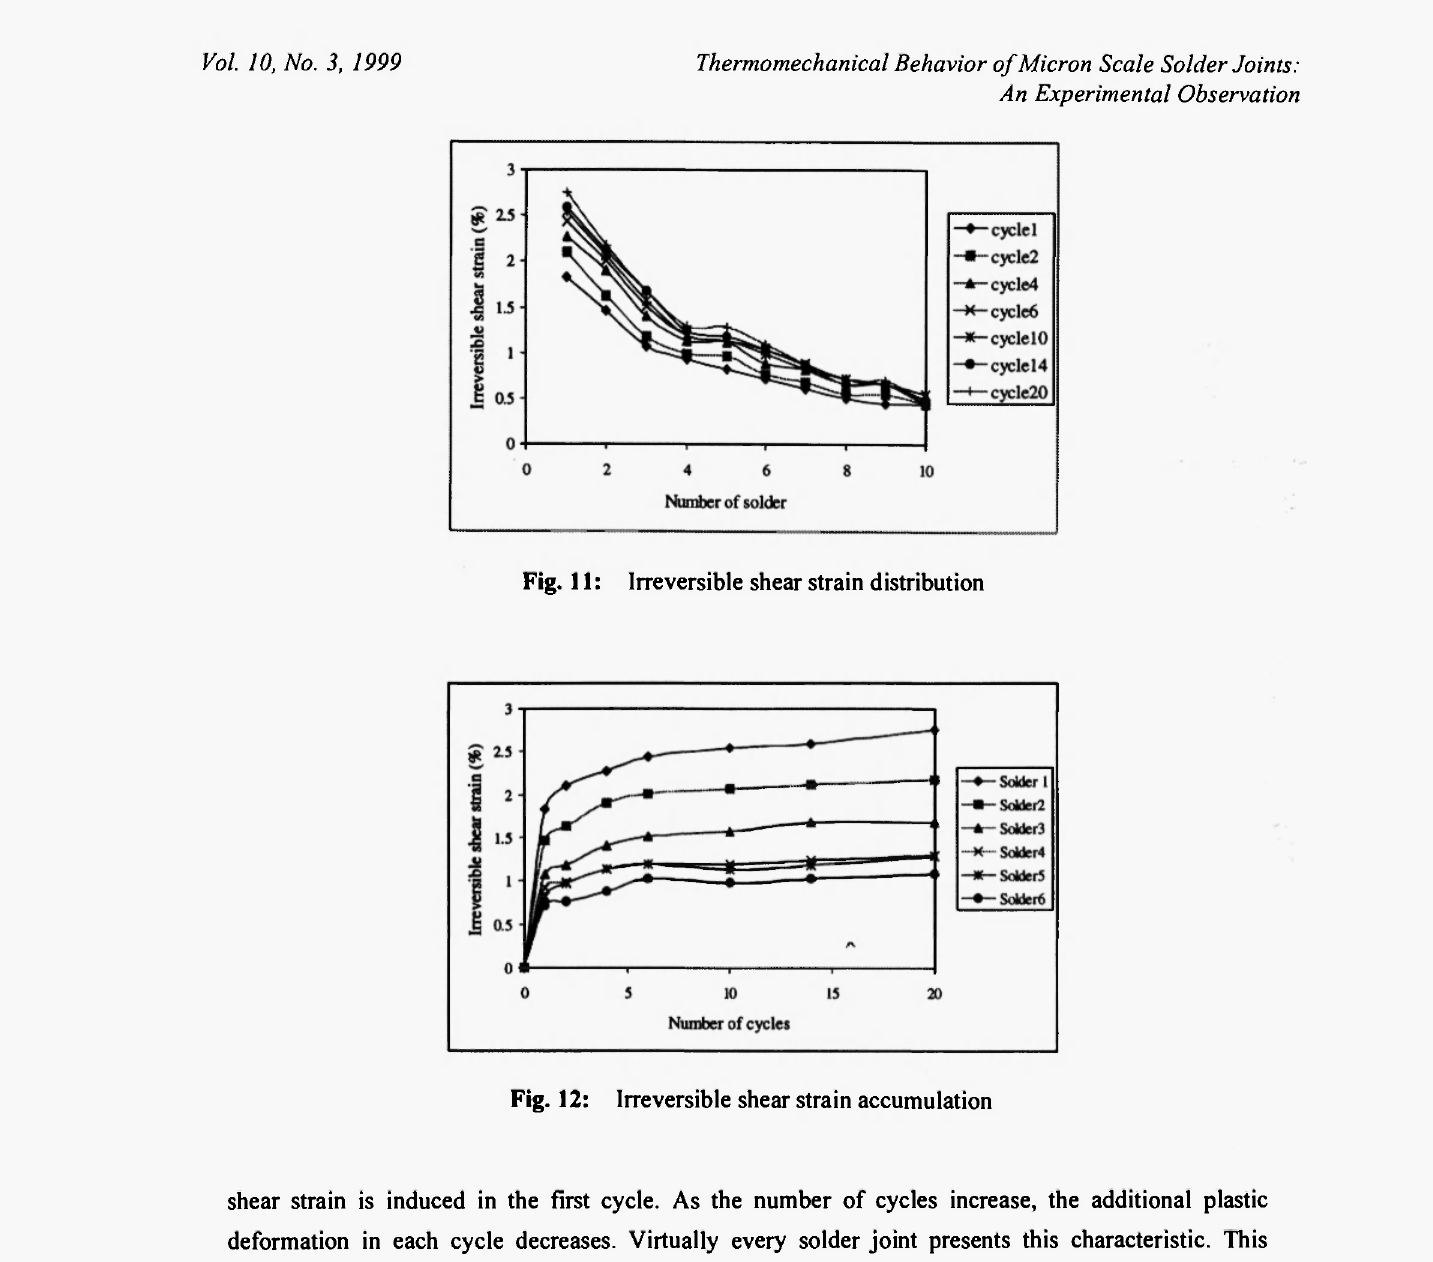
Fig. 12: Irreversible shear strain